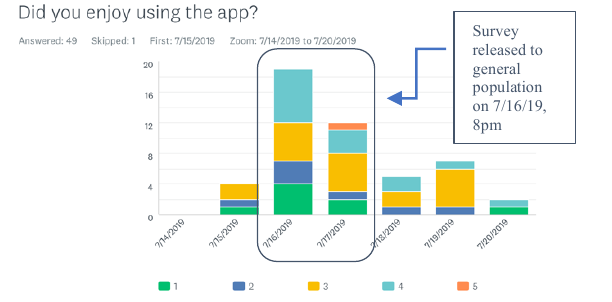
Figure 12. Time trend, Question 7. More respondents report enjoying the app on 7/16 –